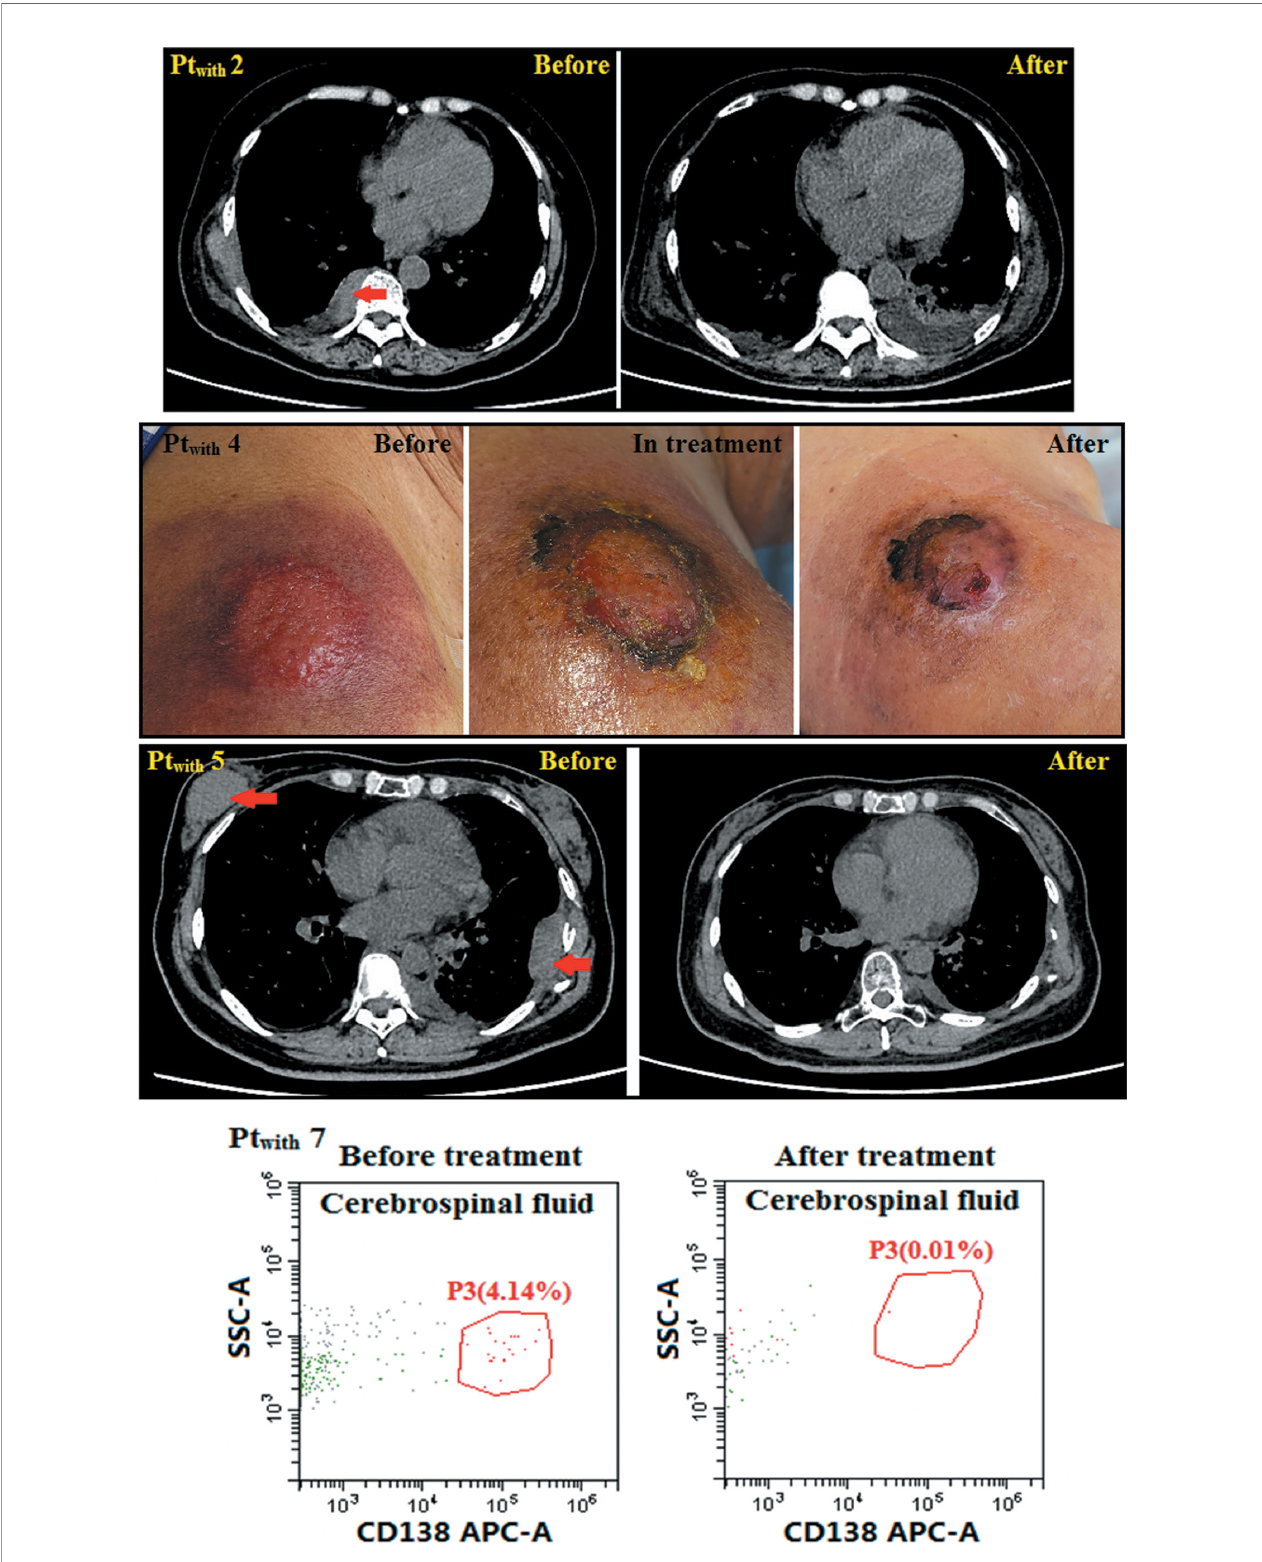
FIGURE 3 | The ef fi cacy to the extramedullary disease. The skin lesion far from bone of Pt with 4 disappeared after anti-BCMA CAR-T cell therapy. Myeloma cells in cerebrospinal fl uid of Pt with 7 disappeared after therapy. Soft tissue masses disappeared after this